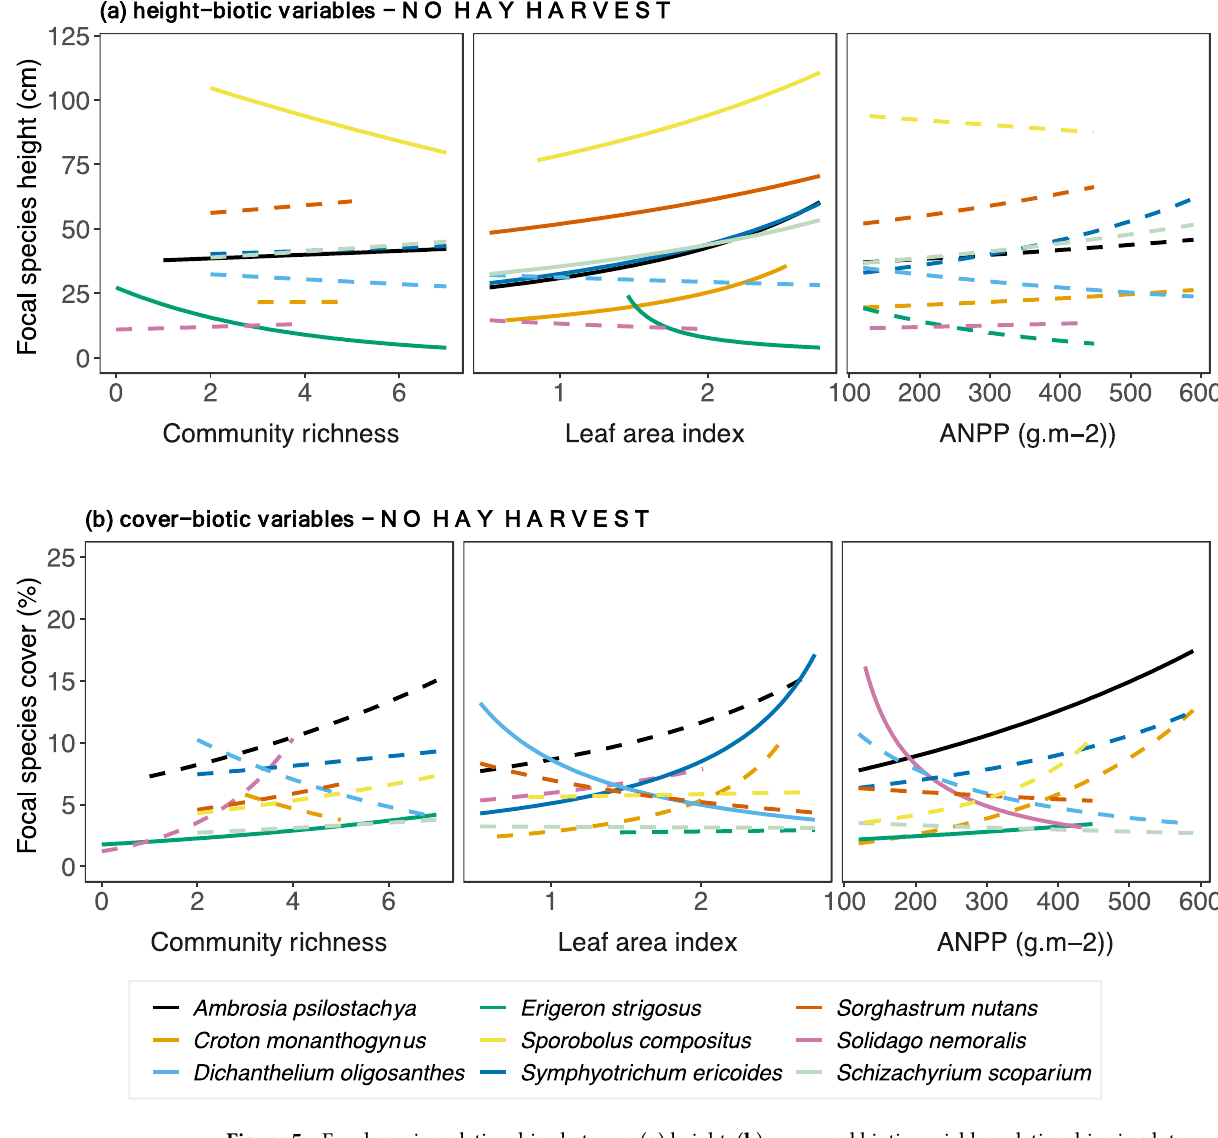
Figure 5. Focal species relationships between ( a ) height, ( b ) cover and biotic variables relationships in plots with no hay harvest across the precipitation gradient. Relationships were estimated by fitting Generalized Linear Mixed Models with log link to both species-specific cover and biotic variables (community richness, leaf area index, above-ground net primary productivity). Continuous lines indicate significant relationships, while dashed lines indicate non-significant. P -values are shown in Table